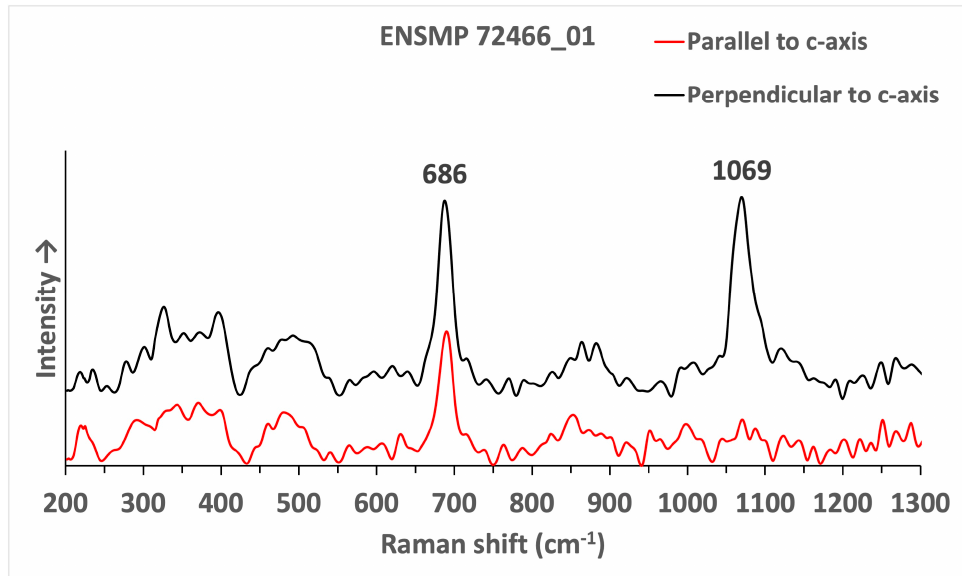
Figure 7. Raman spectra (ENSMP 72466_01) obtained using a mobile instrument with 532 nm laser excitation in the range of 200 to 1300 cm − 1 parallel (red line) and perpendicular (black line) to the c-axis. The upper spectrum has been vertically offset for better clarity. Characteristic bands at 686 and 1069 cm − 1 are mentioned. The Raman spectra were baseline corrected.